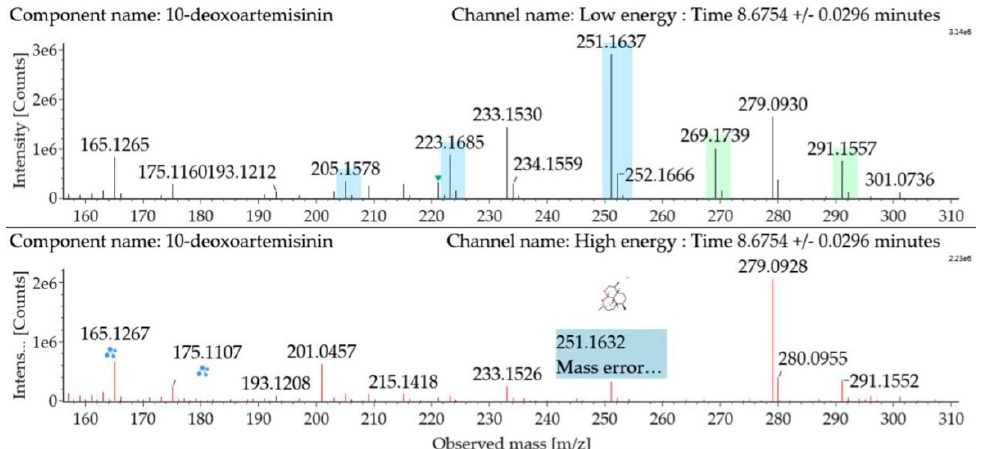
Figure 2. ultra-performance liquid chromatography-electrospray ionization-quadrupole time-of-flight mass spectrometry (UPLC-ESI-Q-TOF-MS E ) spectra and fragmentation diagram of 10-deoxoartemisinin.